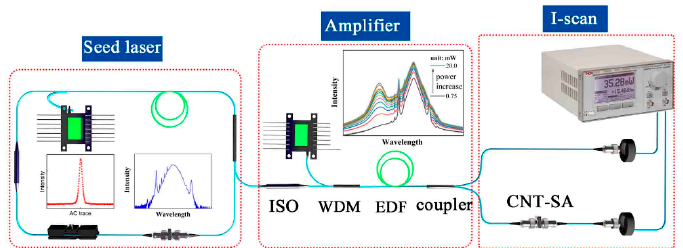
Figure 7. ( a , b ) Long-term stabilities of CS and NLP every 1 h sampling over 6 h. 3. Simulation Results From above experimental data, we conclude a saturable absorber with lower modulation depth and no reverse absorption enables the generation of CS, where a saturable absorber with larger loss and reverse absorption leads to NLP. This provides the tunability of pulse-type in one laser system by modifying the SA parameters. A simulation was then conducted to explain the influence of the SA parameters on laser performance. The simplified numerical model of cavity setup is shown in Figure 8 with a piece of Er- doped gain fiber (EDF), three segments of single-mode fiber (SMF1, SMF2, and SMF3), an optical coupler (OC), a wavelength division multiplexer (WDM), and a saturable absorber (SA). The cavity parameters in simulation are estimated from experimental data which were shown in Table 1, including the same cavity length, relative position of each device, and the same net cavity dispersion. Saturable coefficient and reverse absorption coefficient are described by the transmittance function in Equation (1). To simulate the transformation of pulse operation states in the fiber laser, coherently coupled nonlinear Schrödinger equation (NLSE) including dispersion, nonlinearity, gain, and loss was used as the master equation to describe the pulse propagation in the fiber system (Equations (2) and (3)).